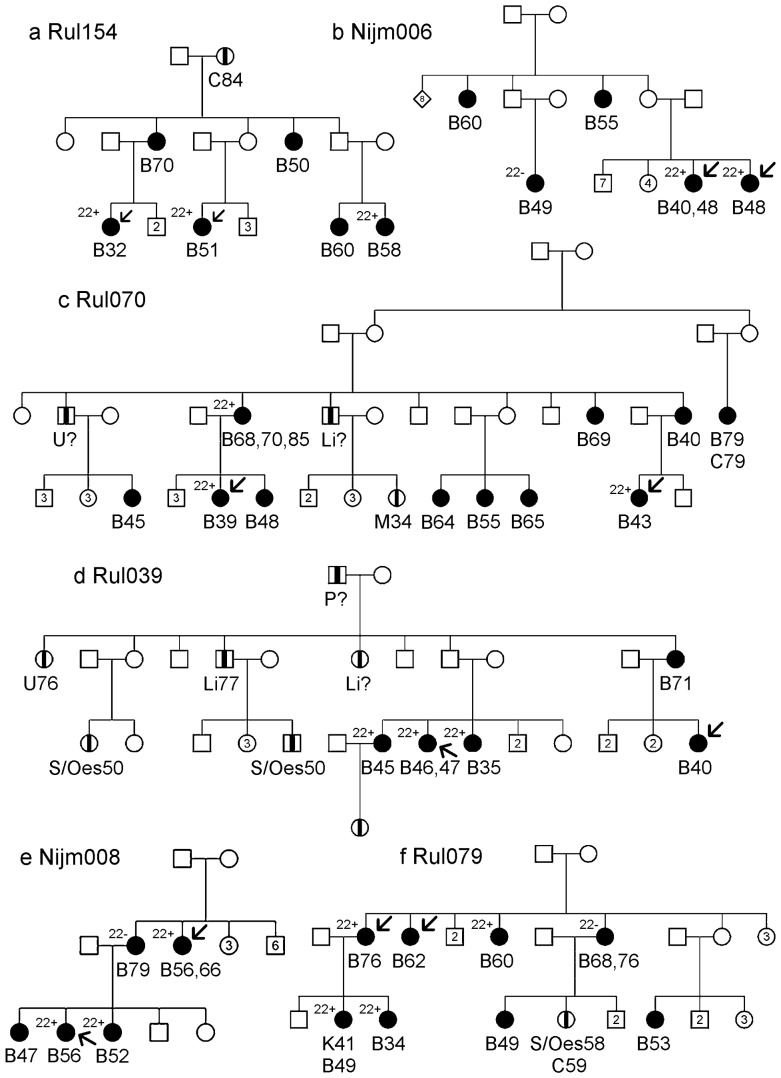
Pedigrees of the families in which multiple tumours showed the “22-gain-like” aCGH profile.Individuals affected with breast cancer are represented by a filled square or circle. Individuals affected by another type of cancer are represented by a square or circle with a vertical black stripe. Below the age at diagnosis and type of cancer can be found: B stands for breast cancer, Li or liver cancer, S for stomach cancer, Oes for oesophagus cancer, C for colon cancer, M for melanoma, Cvx for Cervix cancer, K for kidney cancer, P for prostate cancer and U for type of cancer unknown. Arrows point at the individuals at whose DNA was used for exome sequence. Individuals with tumours with and without the “22-gain-like profile” are represented by “22+”and “22−”.